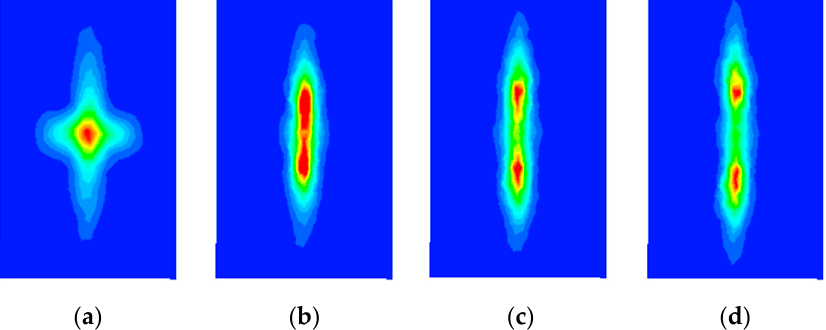
Figure 13. Coating film thickness contours when L = 40 mm: ( a ) θ = 0°; ( b ) θ = 5°; ( c ) θ = 10°; ( d ) θ = 15°.